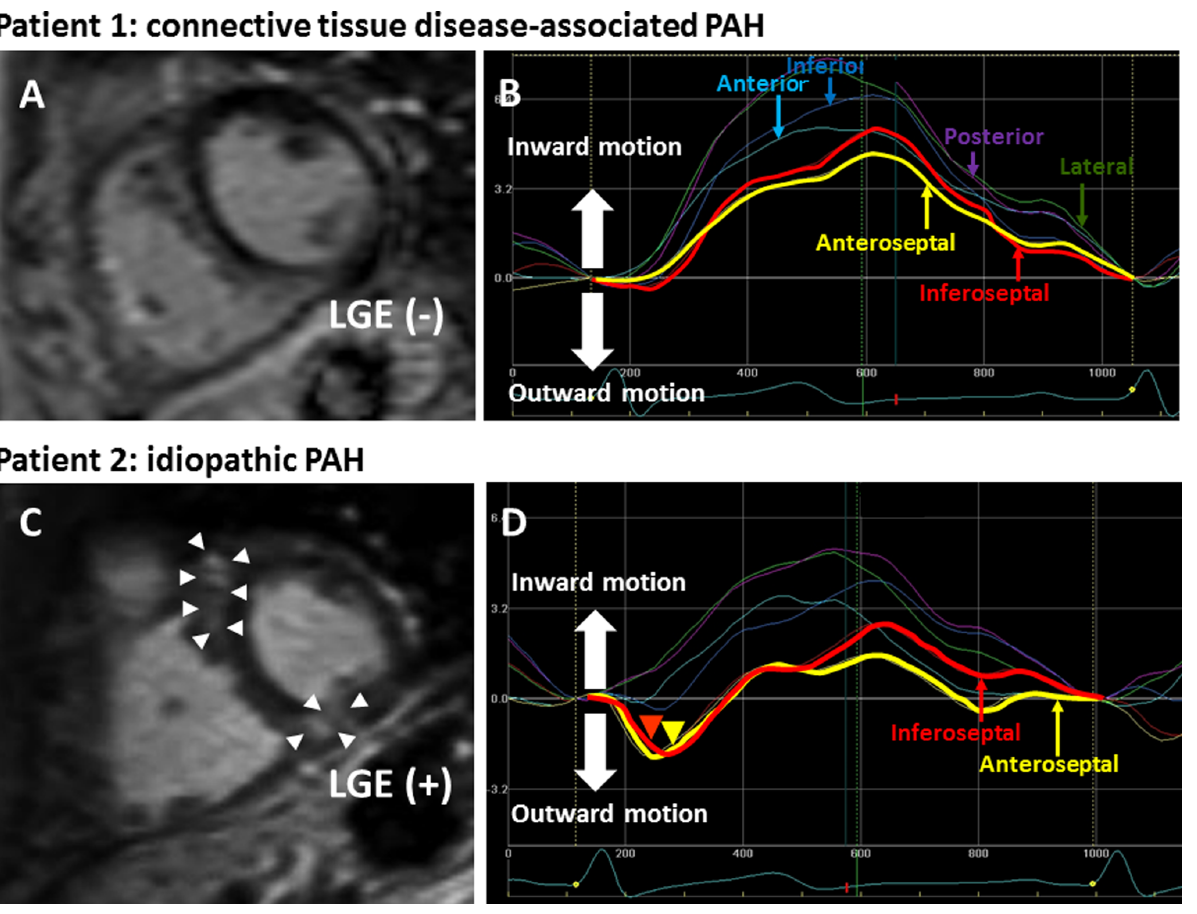
Figure 1. Representative images of cardiac magnetic resonance and speckle tracking echocardiography with or without late gadolinium enhancement and paradoxical motion of the interventricular septum. Patient 1 had connective tissue disease-associated PAH with a mean pulmonary artery pressure of 43 mmHg. CMR (A) shows no late gadolinium enhancement at ventricular insertion points. There is no paradoxical motion of the interventricular septum by speckle tracking echocardiography (B). Patient 2 had idiopathic PAH with a mean pulmonary artery pressure of 37 mmHg. Late gadolinium enhancement at ventricular insertion points is shown in a CMR image (arrow heads, C), and paradoxical motion of the interventricular septum at early systolic phase (arrow heads) is also noted on speckle tracking echocardiography (D). PAH, pulmonary artery hypertension; CMR, Cardiac magnetic resonance.